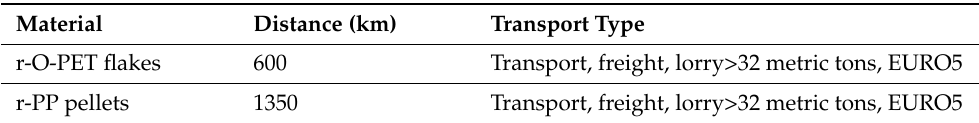
Table 2. Transport stages included in the system boundaries from plastic recyclers to pilot scale extrusion plants.